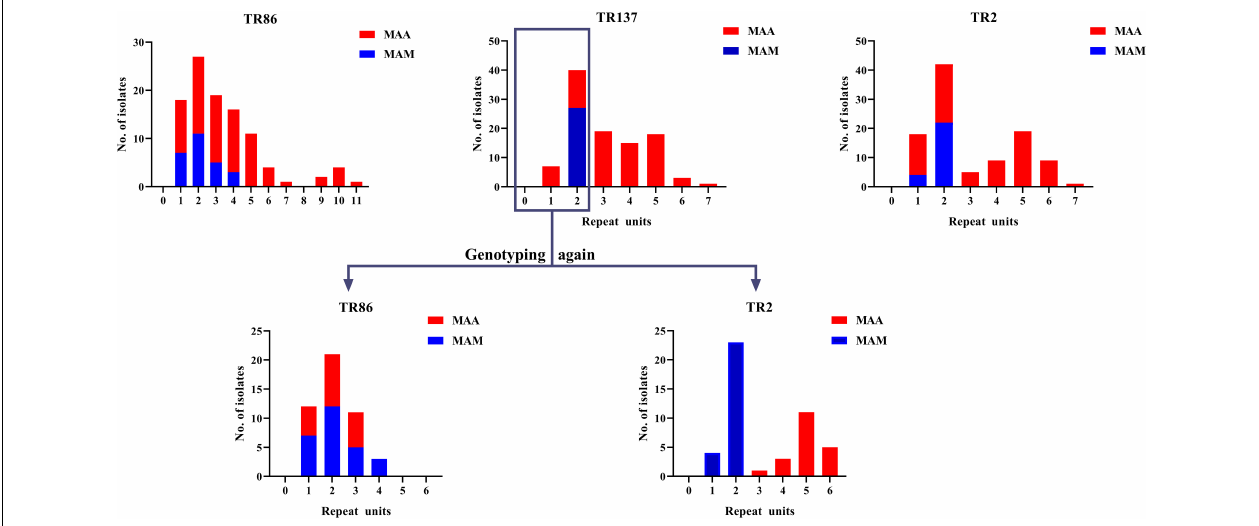
FIGURE 3 | Statistical analysis of Mycobacterium abscessus subsp. abscessus (MAA) and M. abscessus subsp. massiliense (MAM) repeats units at 18 tandem repeat (TR) loci showing that the repeat units of the MAM isolates were less than 3 only at TR137 and TR2 of the 18 TR loci (top). When the strains with TR137 repeat units less than 3 were detected again, only the TR2 locus could completely distinguish MAM from MAA (bottom).